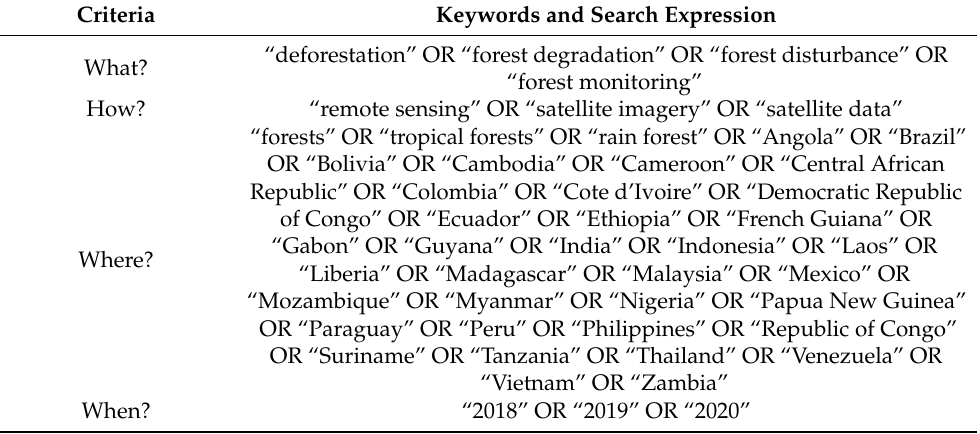
Table 2. Search expression used in the Scopus